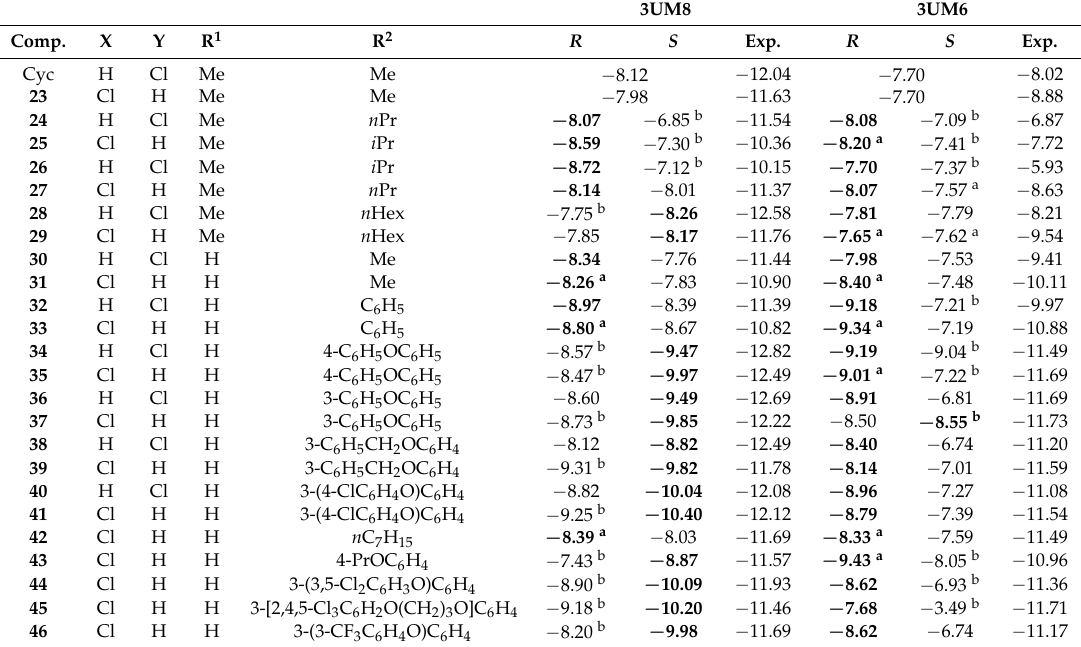
Table 1. Binding energy of Cyc derivatives (kcal mol –1 ) for binding with the wild-type Plasmodium falciparum dihydrofolate reductase ( pf DHFR) (3UM8) and mutant (A16V + S108T) pf DHFR (3UM6) obtained from molecular docking calculations and experimental